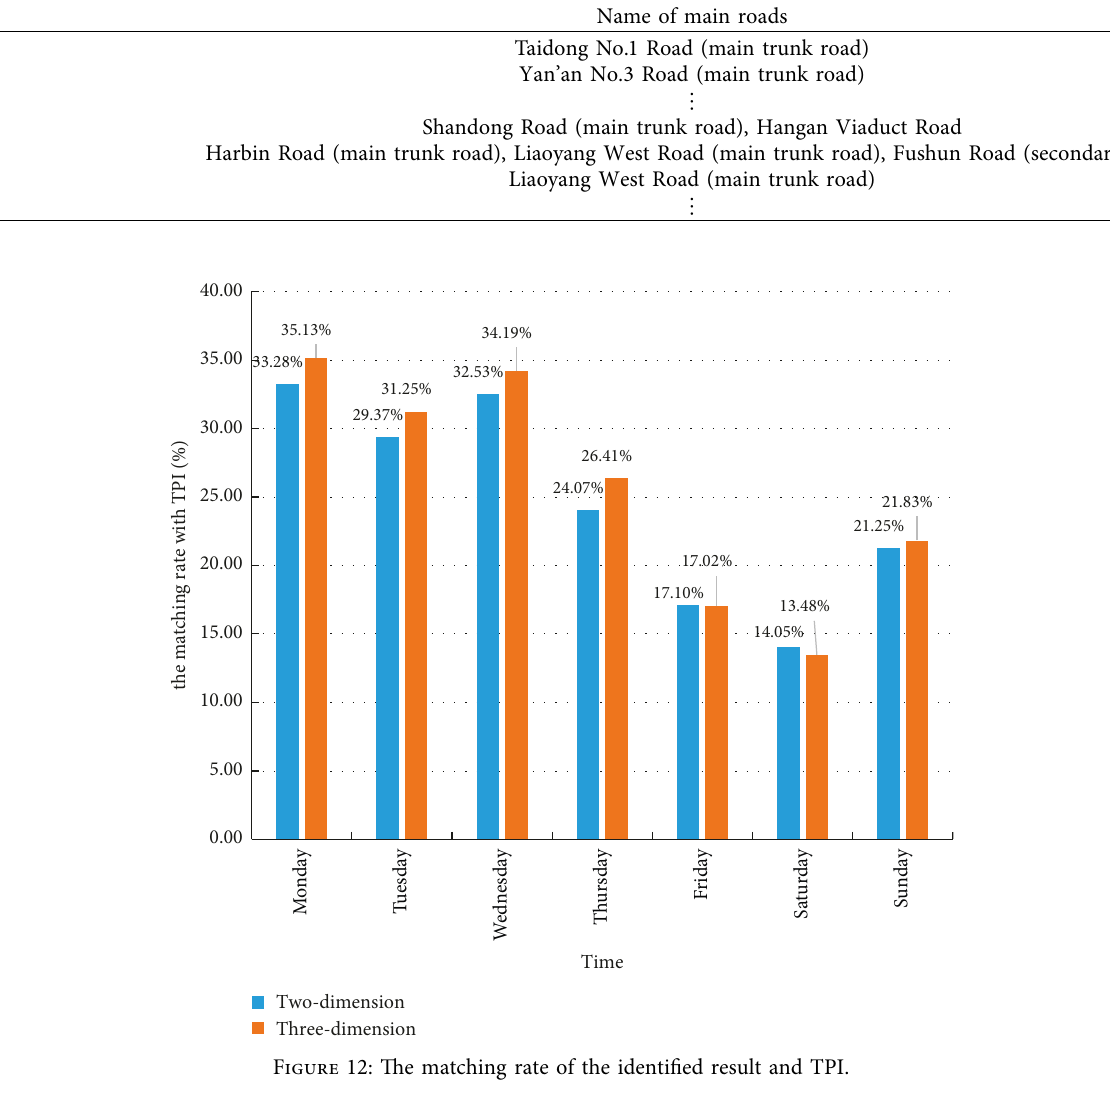
Table 7: Major roads’ status within the grid.